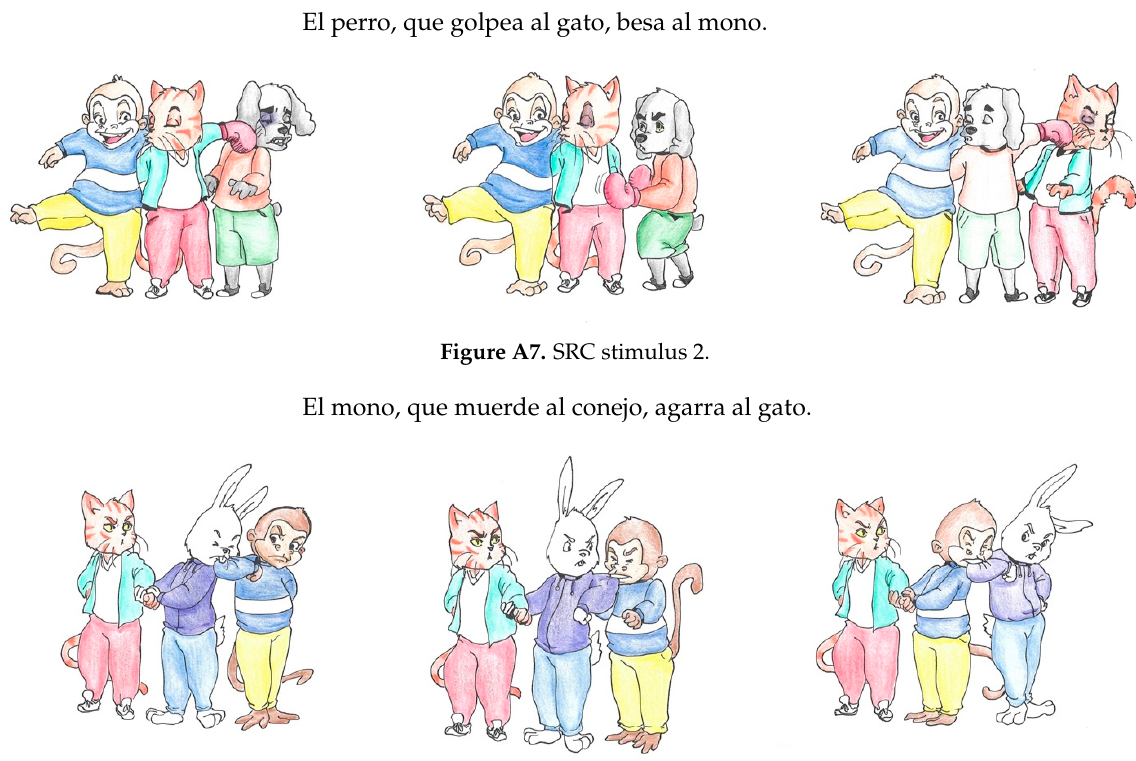
Figure A6. SRC stimulus 1.